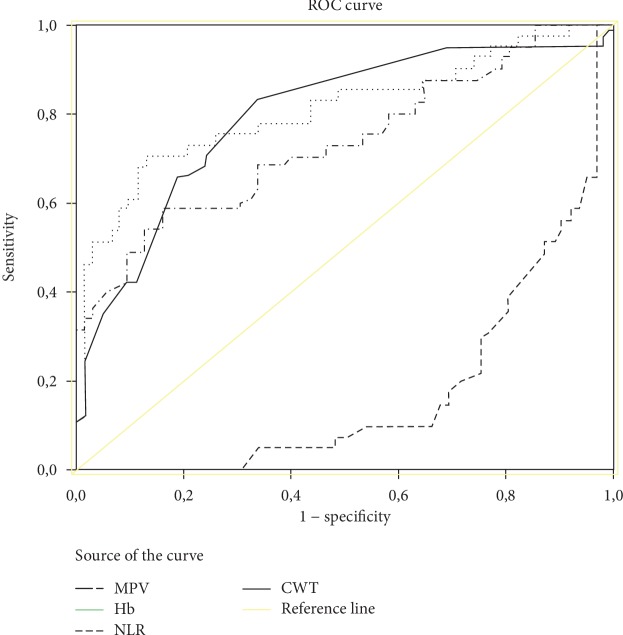
Receiver operating characteristic (ROC) curve analyses of significant parameters for the diagnosis of colon cancer. CWT: colon wall thickness; Hb: hemoglobin; MPV: mean platelet volume; NLR: neutrophil-to-lymphocyte ratio.